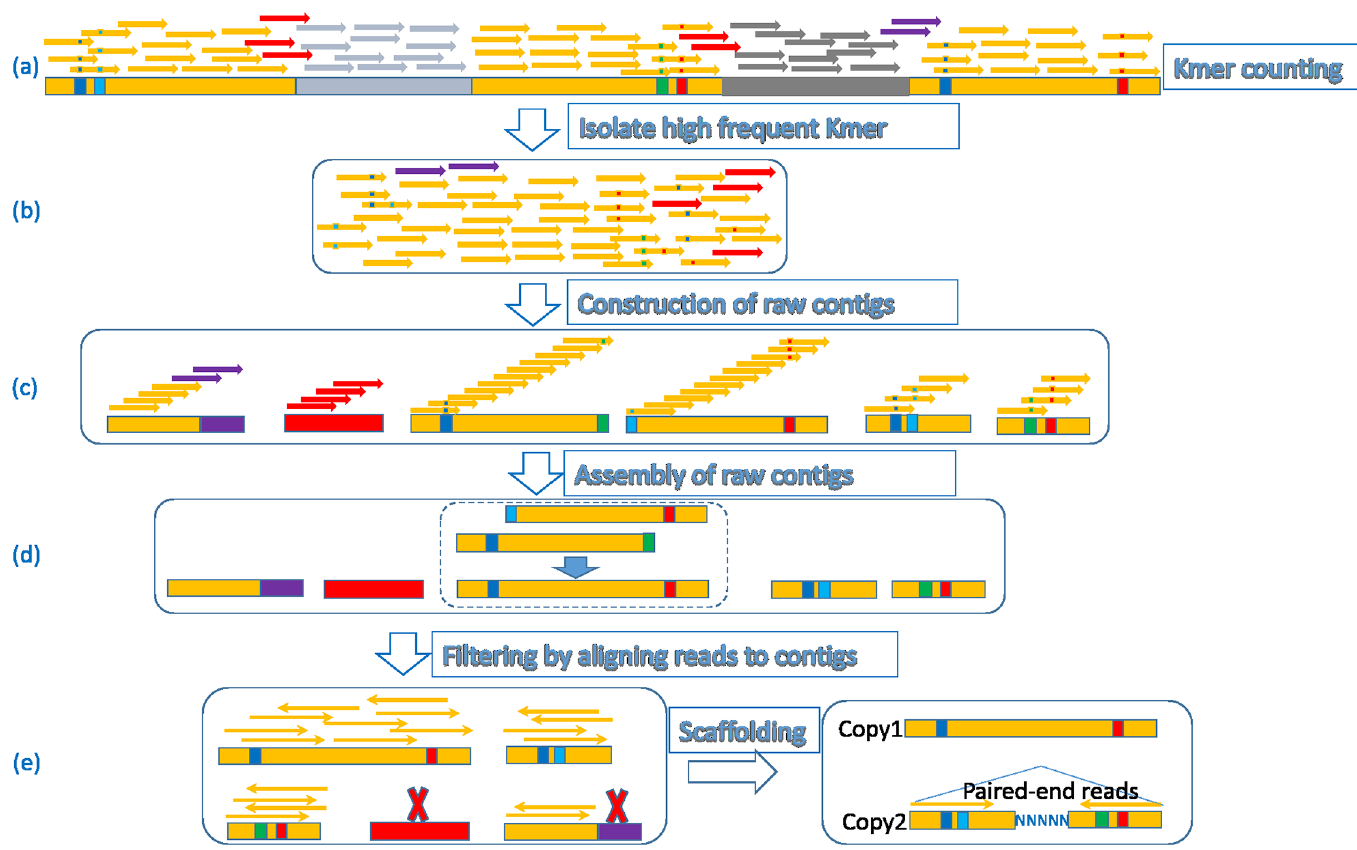
Fig 2. Illustration of the main steps of REPdenovo. Thick bars: genomic sequences. Thin bars: k-mers. K-mer counting step: yellow parts are repeats (with some mismatches). Colored squares within thick bars: mutations (substitutions and indels) within